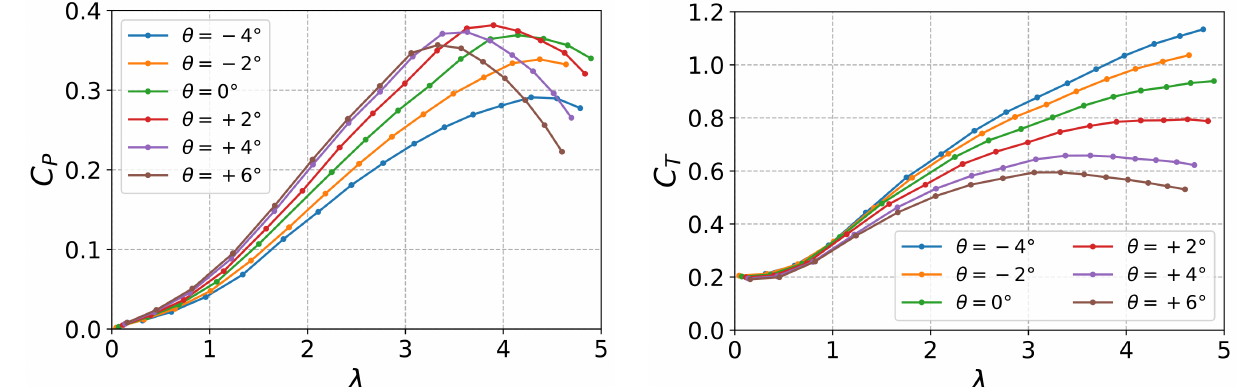
Figure 5. C P and C T at variable tip speed ratio and collective pitch